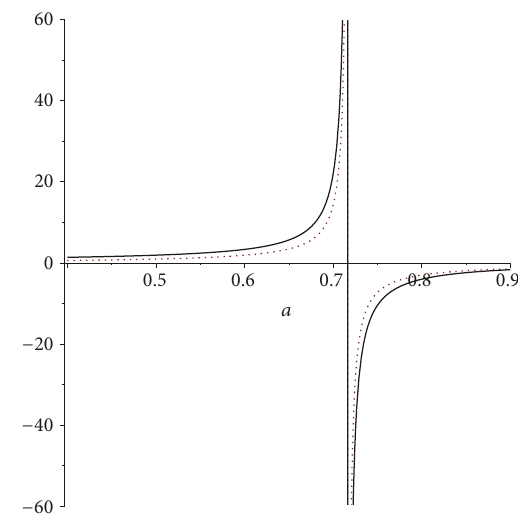
Figure 1: Here, 𝑤 0 = −1 , dot and solid lines represent 𝑤 and 𝑞 ,